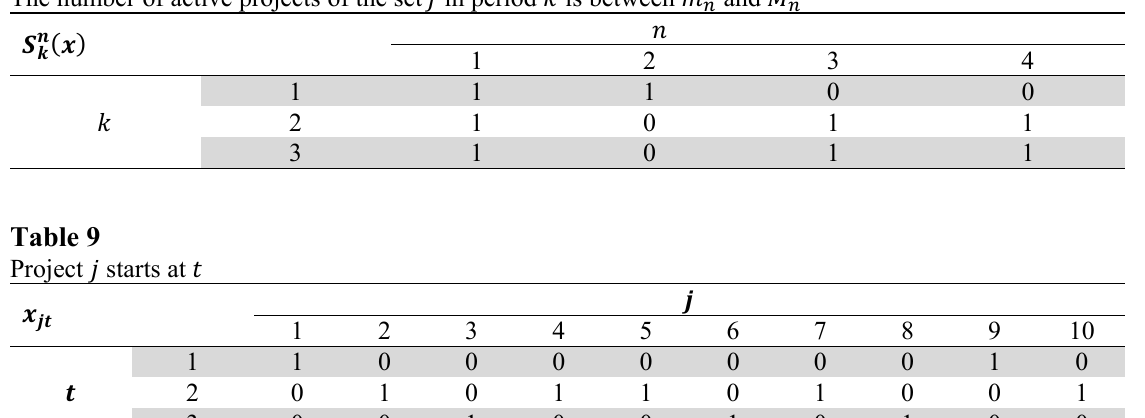
According to the data presented in Tables 1 to 7, after solving the model with the software Gams, we conclude that starts in the first period of projects 1 and 9, in the second period of projects 2, 4, in the first period of projects 1 and 2, in the second period of projects 1, 3 and 4, in the third period